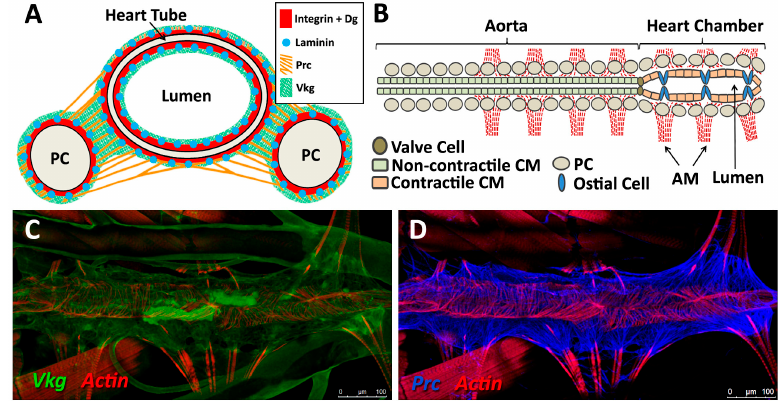
Figure 4. Cont. Figure 4.